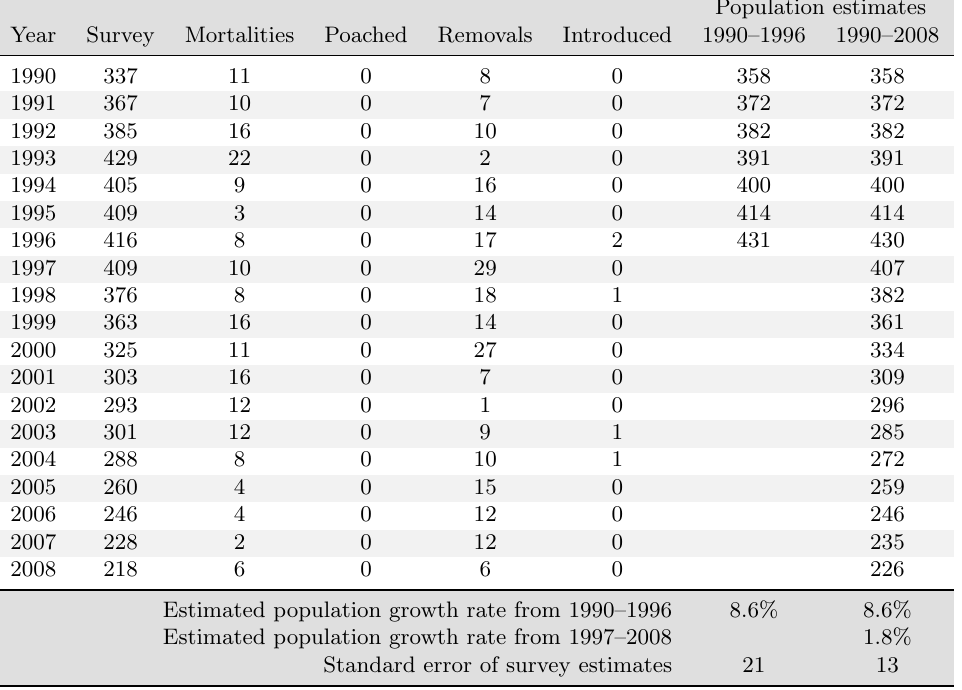
Table 2: Black rhino survey data and population size estimates during the period 1990–2008. of the corresponding survey estimate. The corresponding figure for the standard error of the Black Rhino population size is 16, showing a more modest reduction from that of 21 for the survey